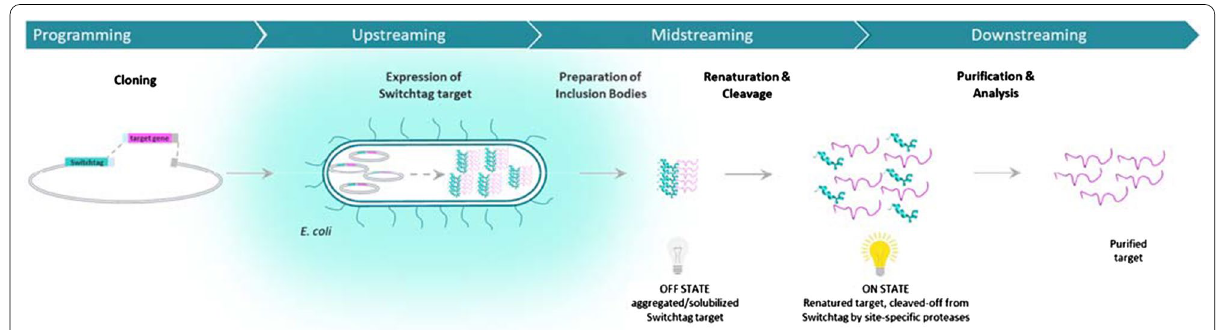
Fig. 2 Schematic view of the Numaswitch approach. Being integrated into an expression cassette and expressed in E. coli , Switchtag targets form inclusion bodies (IBs) inside the cytoplasm (IB‑tag). The IBs are extracted and solubilized. Switchtag targets are subsequently quantitatively renatured in the presence of Ca 2 + ions (renaturation tag). After renaturation targets are separated from the Switchtag by site‑specific proteases releasing traceless products without any non‑desired amino acids remaining